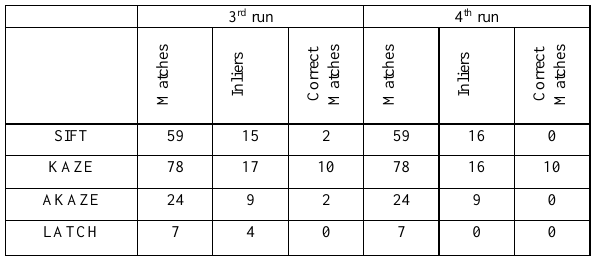
Table 3 Matching results of scene 1 between aerial and panoramic image of the 3rd and 4th